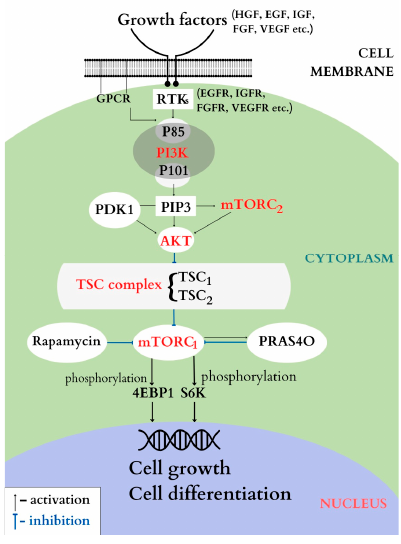
Figure 5. PI3K/AKT/mTOR pathway.